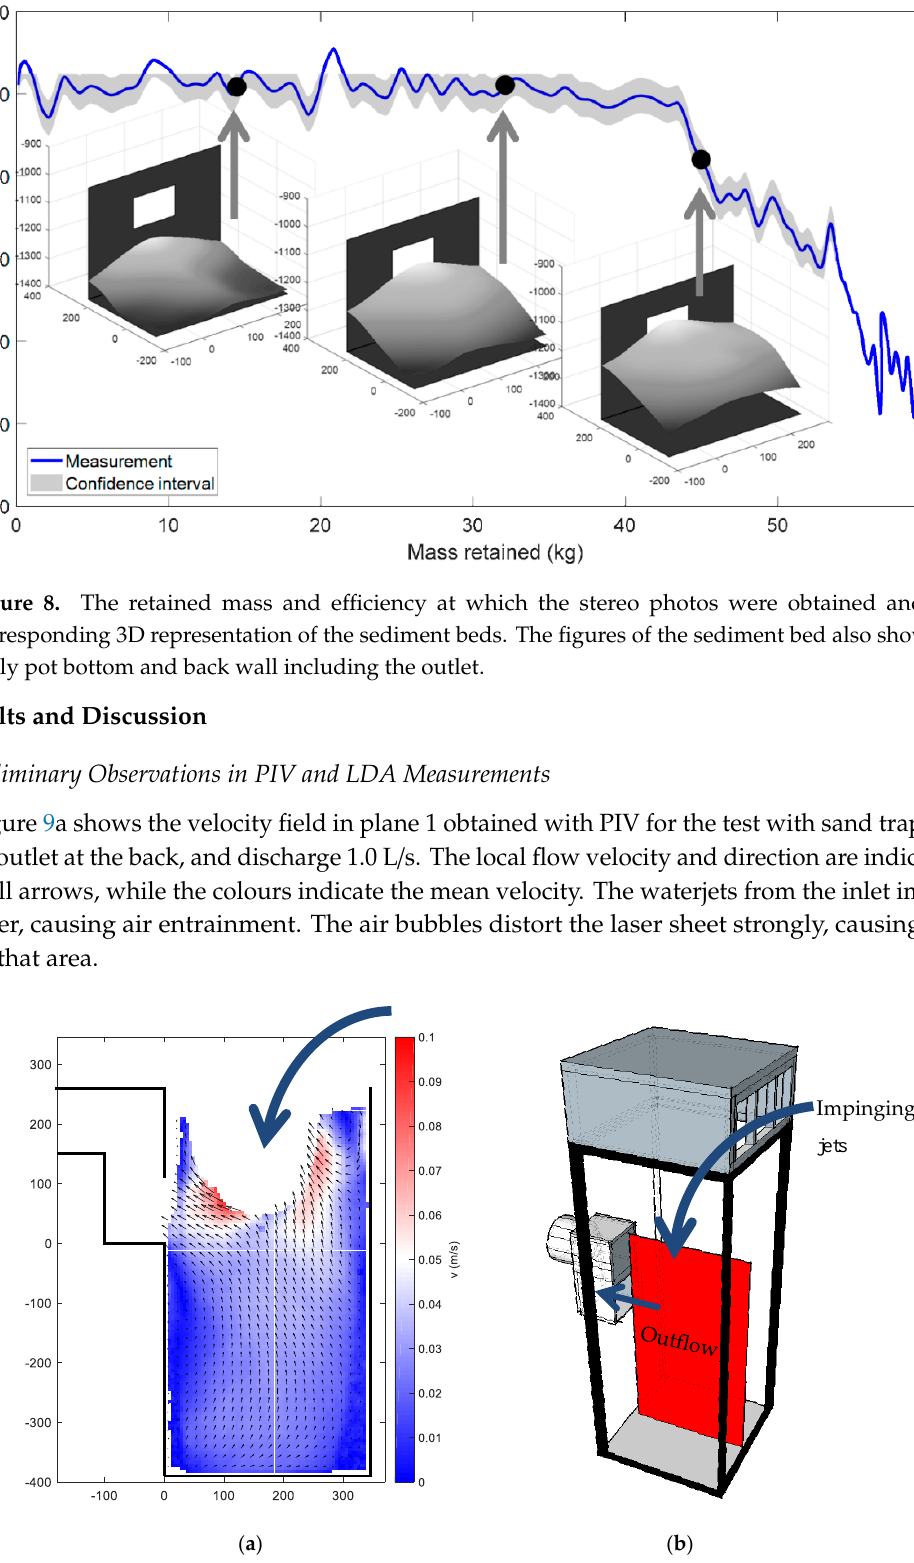
( b ) Figure 7. ( a ) Image used to calibrate the stereo photography setup; ( b ) Image of the sediment bed used to create the artificial sediment bed shown in Figure 6b. The recorded beds originated from a test at a discharge of 1.0 L/s, with the outlet at the back, a gully pot depth of 0.21 m, and sand with a D 50 of 400 µm. The sediment accumulation occurred non- uniformly over the gully pot’s cross-section. The shape of the bed depends on the position of the impinging jets, the particle characteristics, and the gully pot geometry. In this test, all inflowing